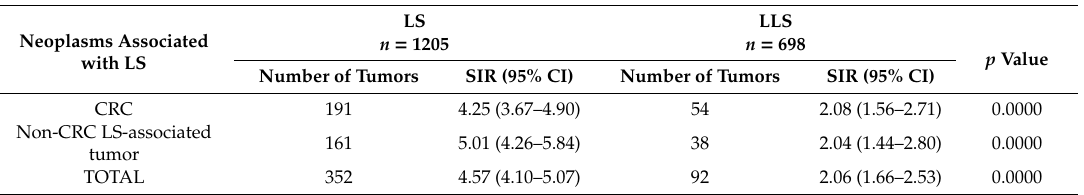
Table 2. SIR of CRC or other neoplasms associated with LS in first-degree relatives of patients with LLS compared with FDR of patient with LS.